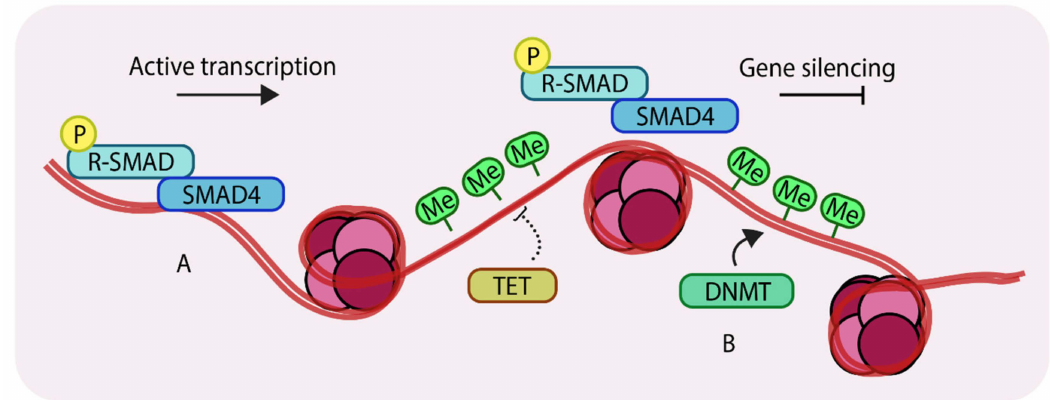
Figure 2. Methylation of genomic DNA. ( A ) unmethylated regions of DNA can allow binding of SMAD components and other transcription factors to enhance gene expression; ( B ) DNA methyltransferases (DNMTs) methylate genomic DNA, which inhibits binding of transcription factors thereby silencing certain genes. Ten-eleven translocation (TETs) antagonize DNMTs by removing methyl groups from DNA. ‘P’ in yellow circles indicates phosphorylation, ‘Me’ in green circles indicates